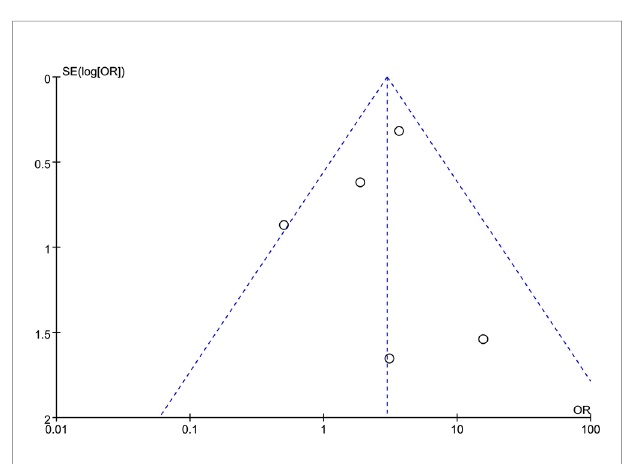
FIGURE 6 | Funnel plots for R0